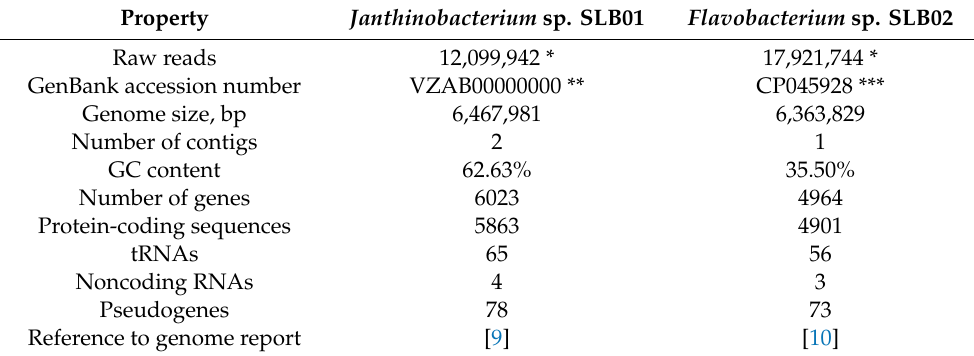
Table 1. Raw reads and genome feature statistics of bacterial strains in this study.